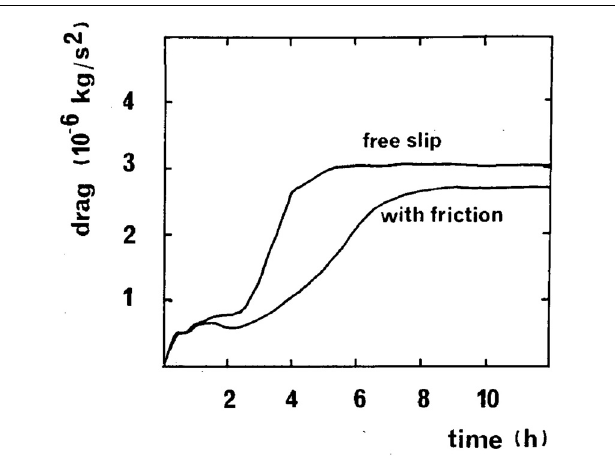
FIGURE 15 | Time evolution of the drag for simulations of flow over 2D orography using free-slip and no-slip lower boundary conditions (see curve labels details). Reproduced from Figure 4 of Richard et al. [155]. © American Meteorological Society. Used with